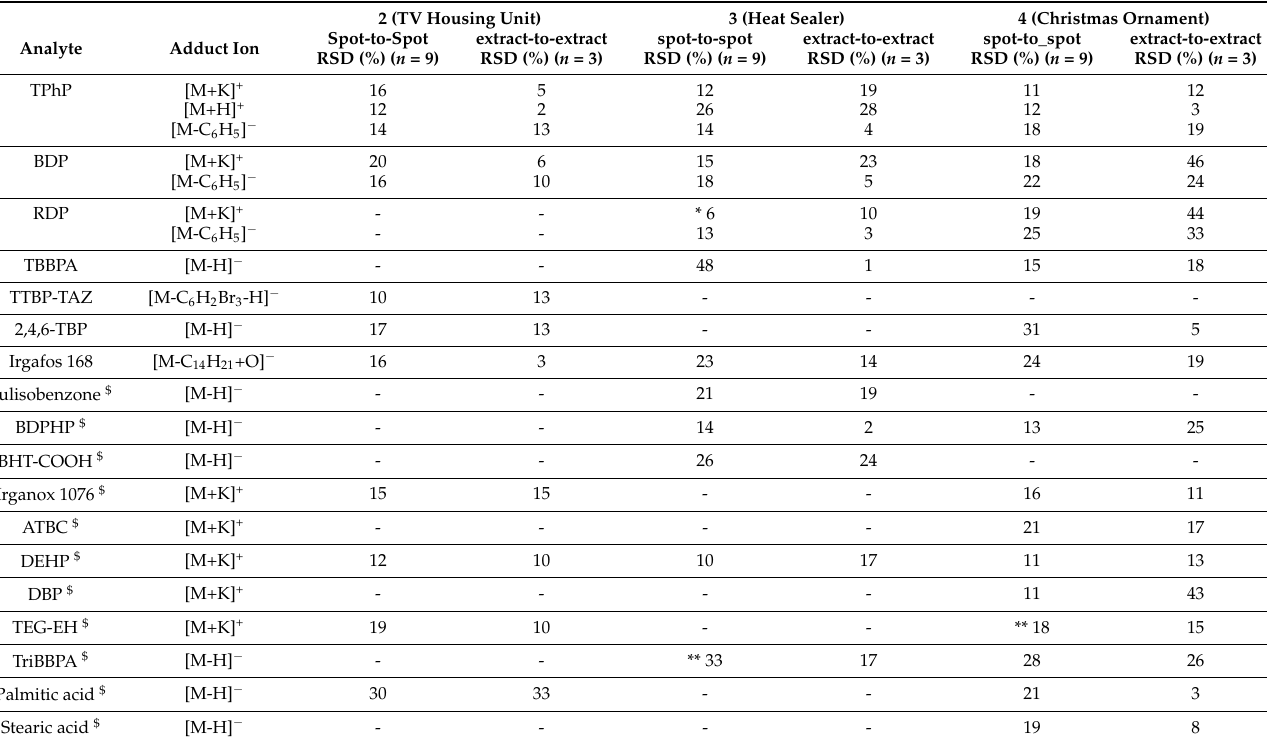
Table 1. Spot-to-spot and extract-to-extract RSD(%) of three plastic samples. The RDP and TriBBPA levels in sample three and the TEG-EH levels in sample four were relatively low; therefore, in some of the measurements, the quantifier ion was not visible, resulting in a non-detect. (*) spot-to-spot RSD(%) based on n=8 instead of n=9. (**) spot-to-spot RSD(%) based on n=7 instead n=9. (-) Analyte not detected in sample). ( $ ) analytes have not been verified with